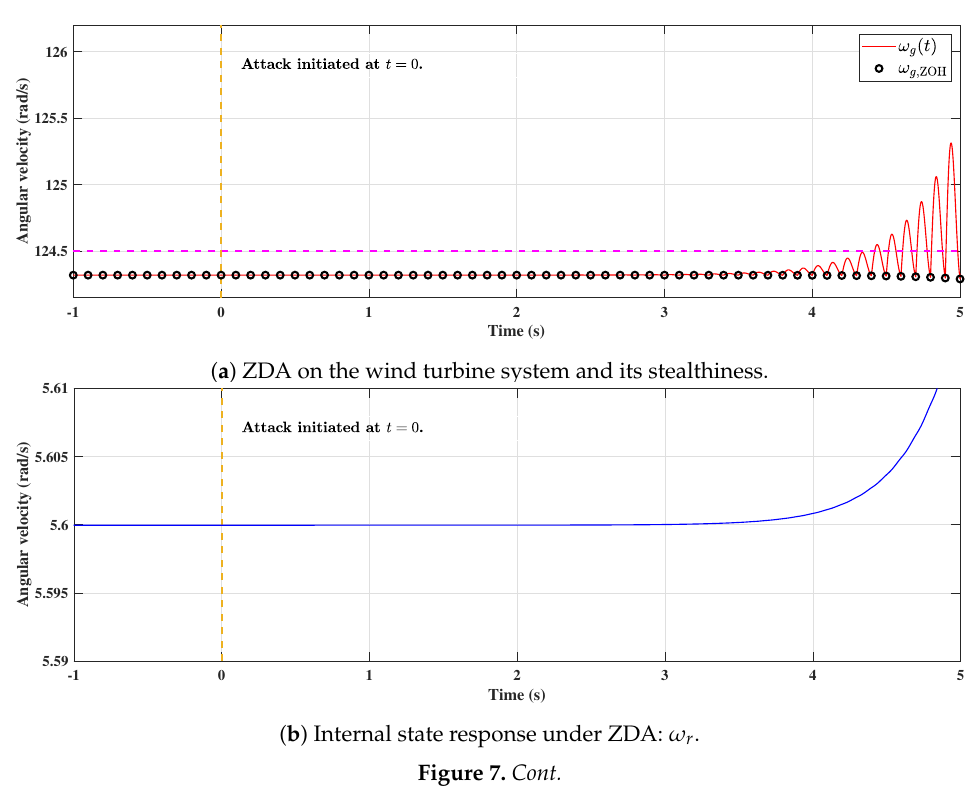
( b ) Internal state response under ZDA: ω r . Figure 7.